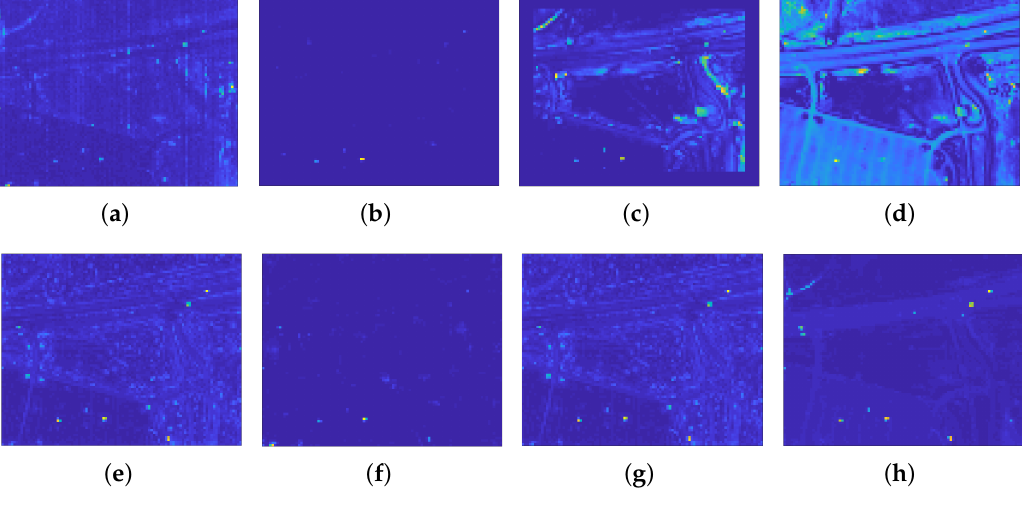
Figure 11. Two-dimensional maps of detection results by different algorithms for the HYDICE dataset.